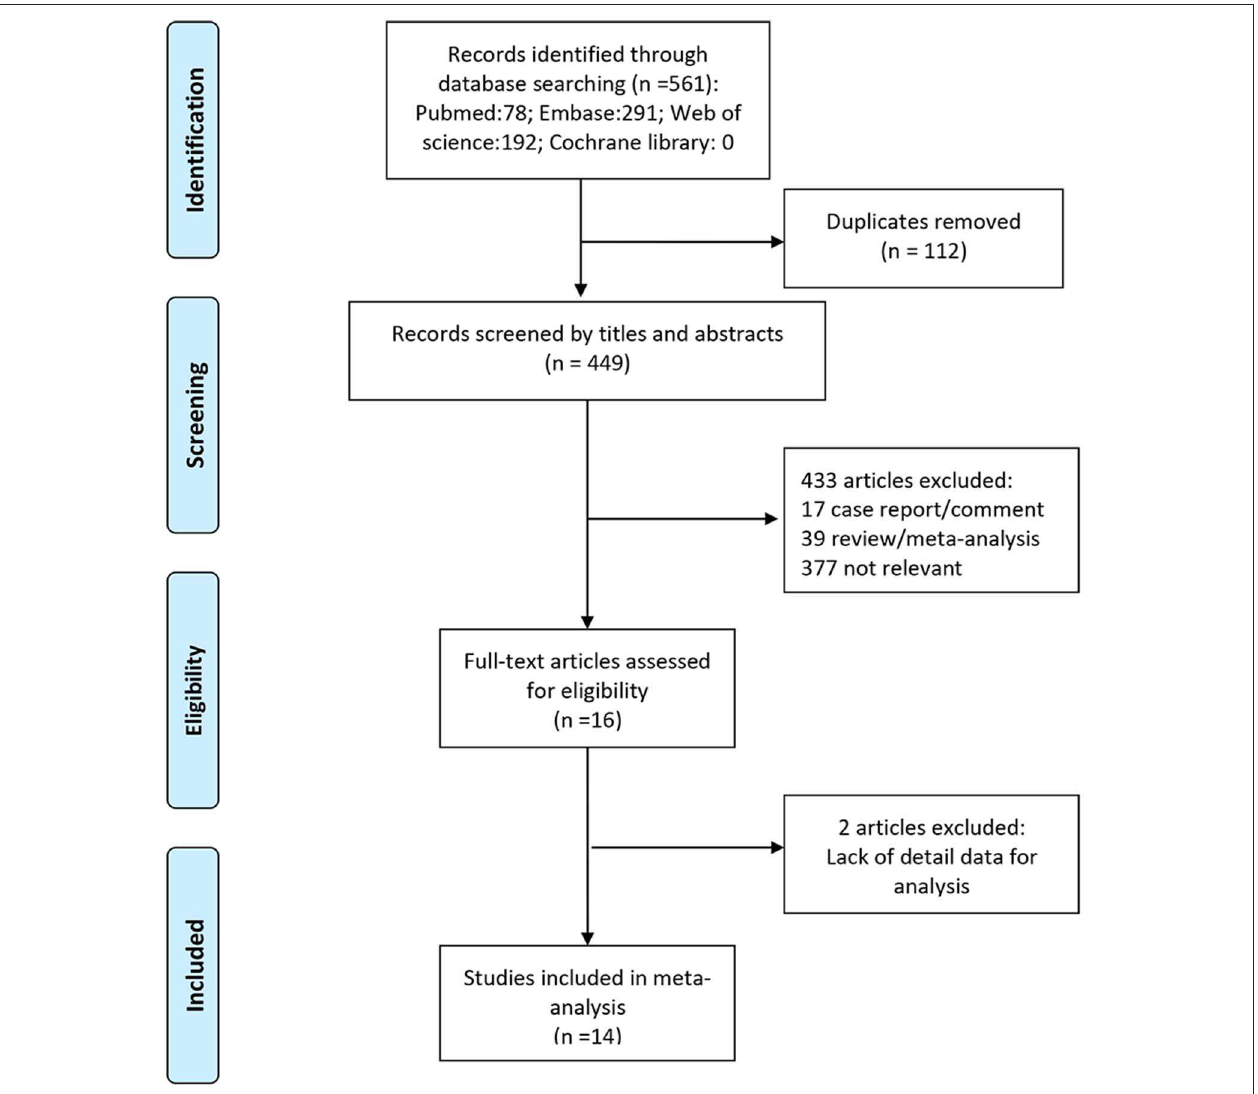
FIGURE 1 | Preferred reporting items for systematic reviews and meta-analyses flow chart of the study selection process, showing the number of studies excluded at each step and the reasons for exclusion from the systematic review and